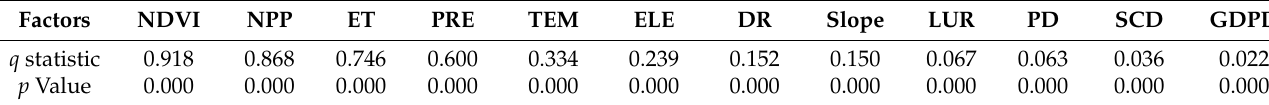
Table 8. Results for different factors of EVI.